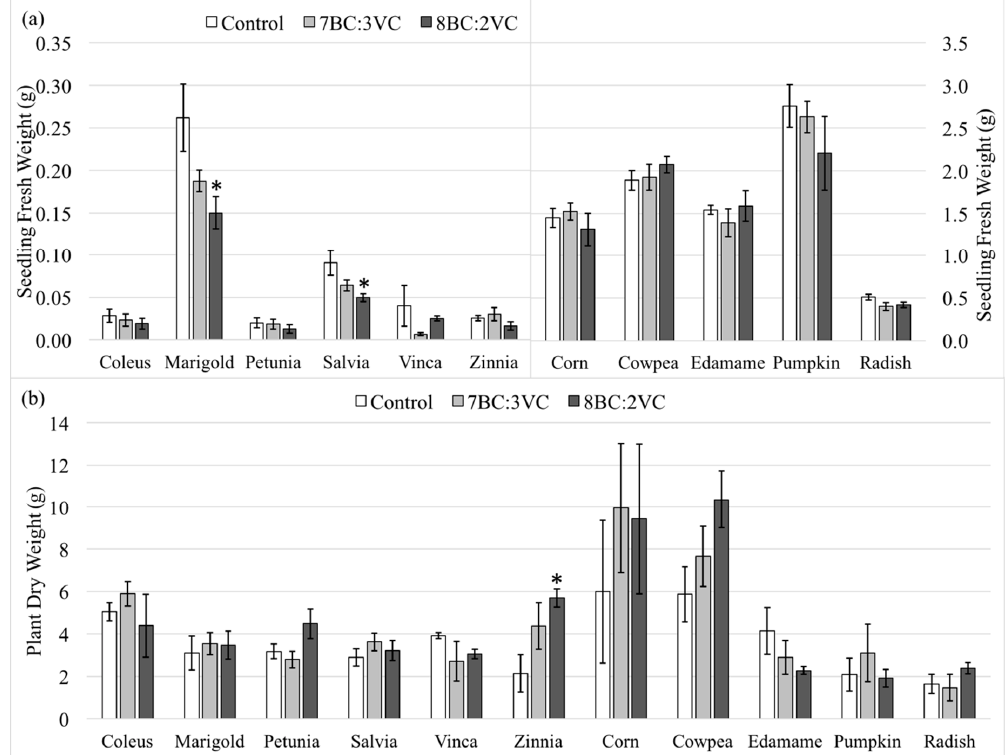
Figure 5. Fresh weights of the seedlings ( a ) and the dry weights of the plants harvested at 7 weeks after transplantation ( b ) (mean ± standard error), which were germinated in commercial propagation mix (control), 70% biochar:30% vermicompost (7BC:3VC, by volume), or 8BC:2VC in Experiment 2. The asterisks indicate differences from the control using Dunnett’s test at p < 0.05 ( n = 4).